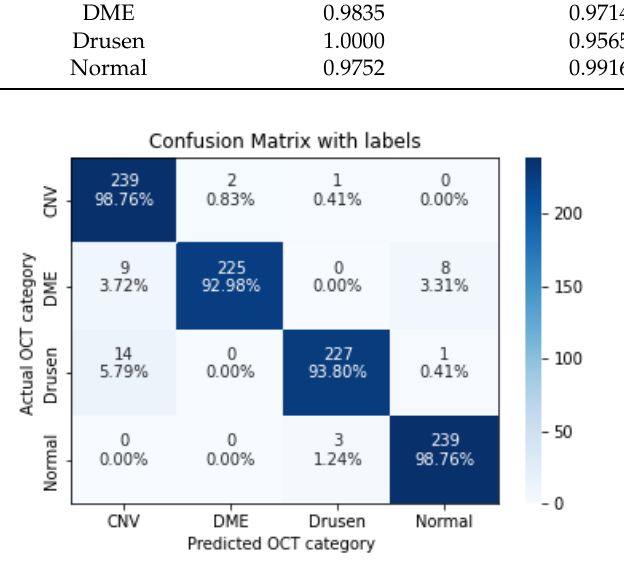
Figure 6. The confusion matrix of 3 layers model, with numbers and percentages.